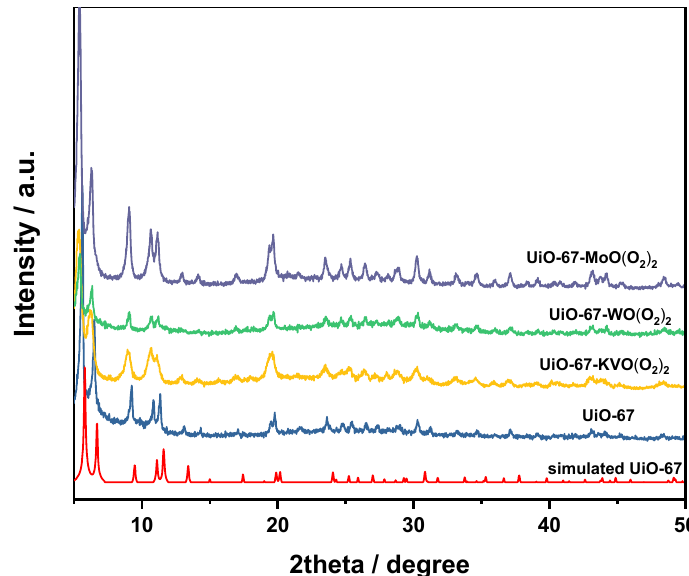
Figure 1. XRD patterns of the simulated UiO-67 and the synthesized UiO-67, UiO-67-MoO(O 2 ) 2 , UiO-67-WO(O 2 ) 2 , and UiO-67-KVO(O 2 ) 2 .